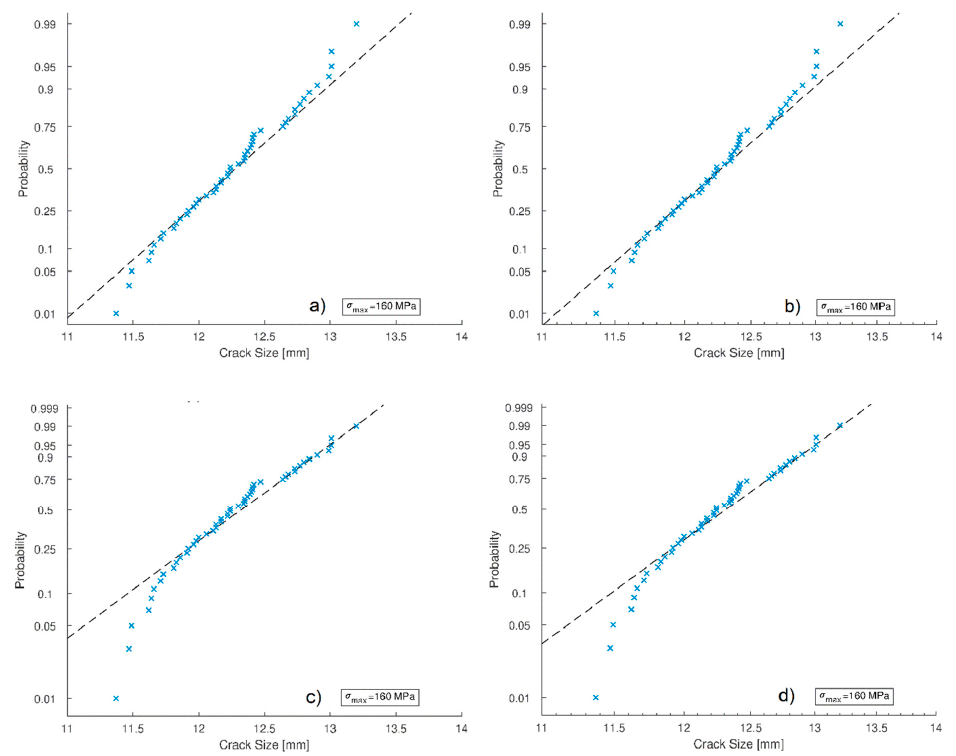
Figure 13. Critical crack size at 160 MPa: probability plots for normal ( a ), log-normal ( b ), extreme value ( c ) and Weibull ( d ) distributions.